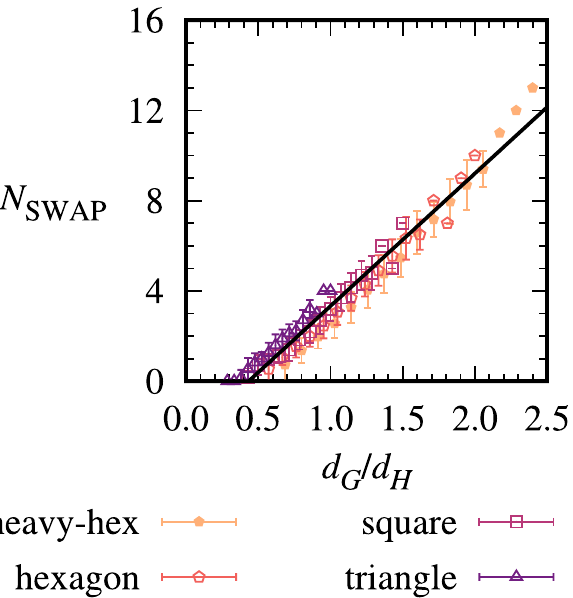
Figure 2. SWAP gate scaling with average problem degree d G and hardware degree d H for 7-vertex graphs. The solid line shows the non-linear least squares fit to N SWAP ( d G , d H ) b 2.5 0.2 , with ± indicating the asymptotic standard error of the fit = − ±